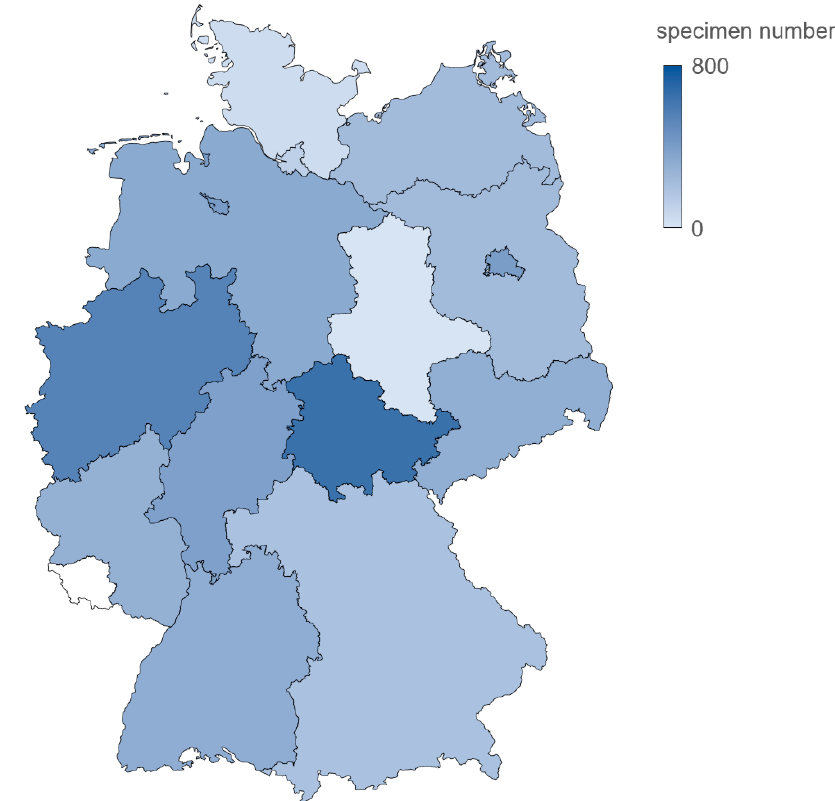
Figure 1. Distribution of specimens collected in Germany, 10/1/2015–09/30/2019. Sentinel practices were distributed over 15 of the 16 German Bundesländer (Federal States). Color codes represent, for each Bundesland (Federal State), the number of specimens collected.